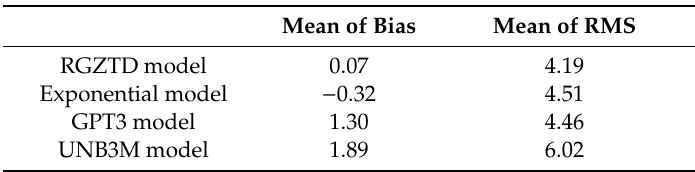
Table 2. Mean bias and RMS of RGZTD model, Exponential model, GPT3 model with respect to radiosonde ZTD data in 2017–2018